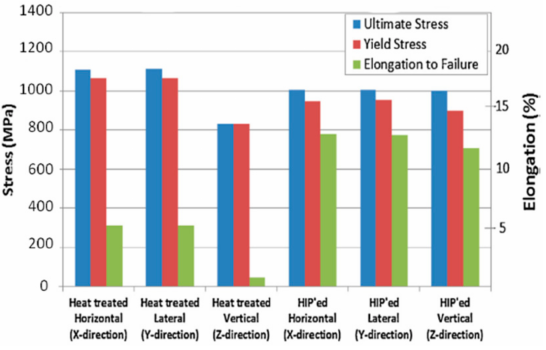
Figure 14. Tensile properties of DEDed Ti-6Al-4V in different building orientations after heat treatment and HIP process (reproduced with permission from [18] Copyright Elsevier, 2015).